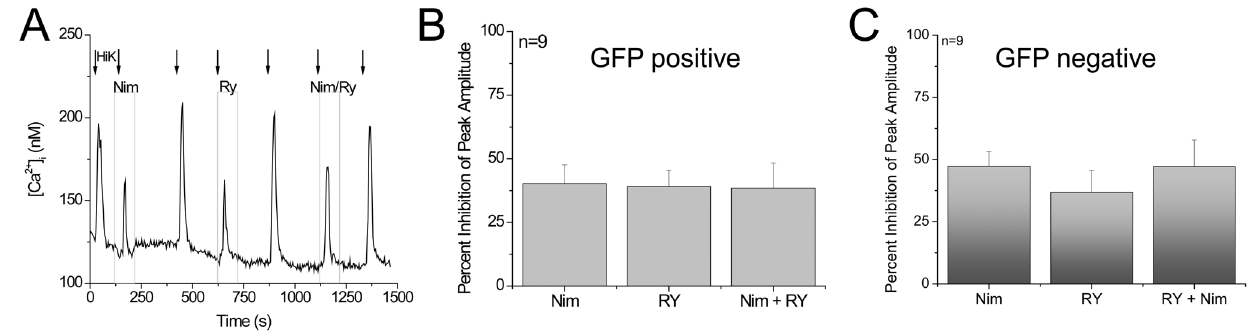
Figure 5. Ryanodine receptors are functionally coupled with L type voltage-gated calcium channels in both GAD-GFP positive and GAD-GFP negative Type III cells. A) Representative trace showing inhibition of the L type calcium channels and ryanodine receptors individually inhibited and then co-inhibited. B) Percent inhibition of the peak amplitude of the evoked calcium influx by nimodipine alone, ryanodine alone and nimodipine + ryanodine together in GAD67-GFP expressing Type III taste cells. No significant differences were detected between the different conditions (n=7, p=0.57). C) Percent inhibition of the peak amplitude of the evoked calcium influx by nimodipine alone, ryanodine alone and nimodipine + ryanodine together in the non-GFP expressing Type III taste cells. No significant differences were detected between the different